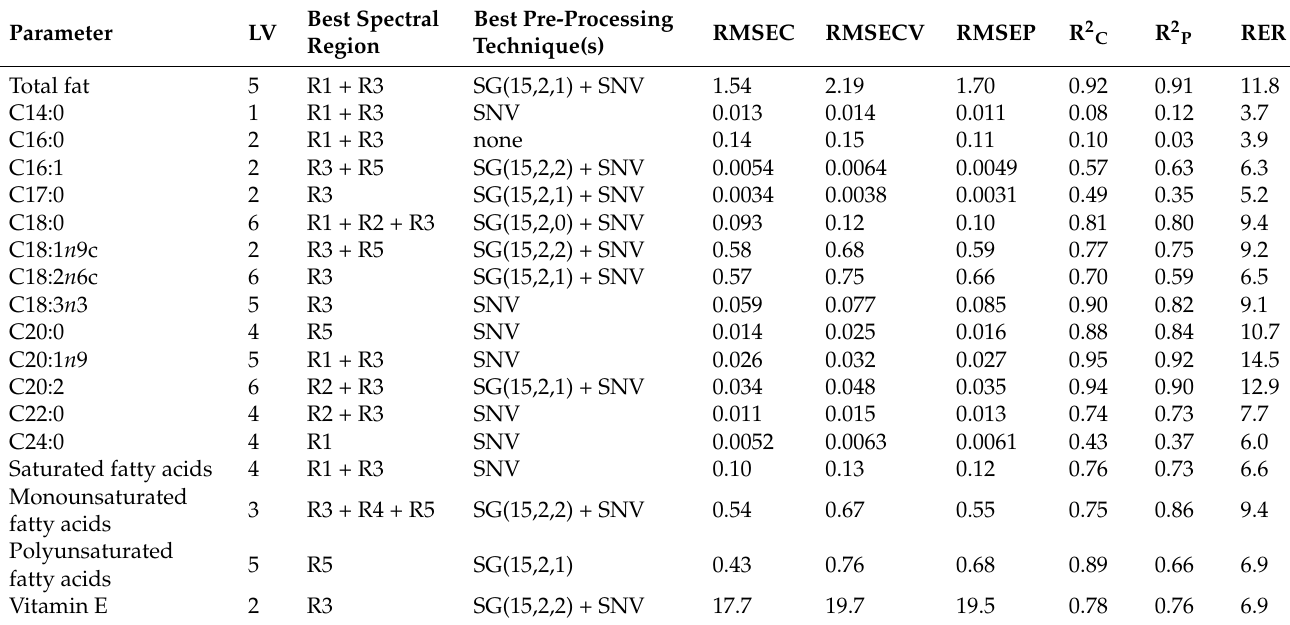
Table 5. Summary of the best PLS models